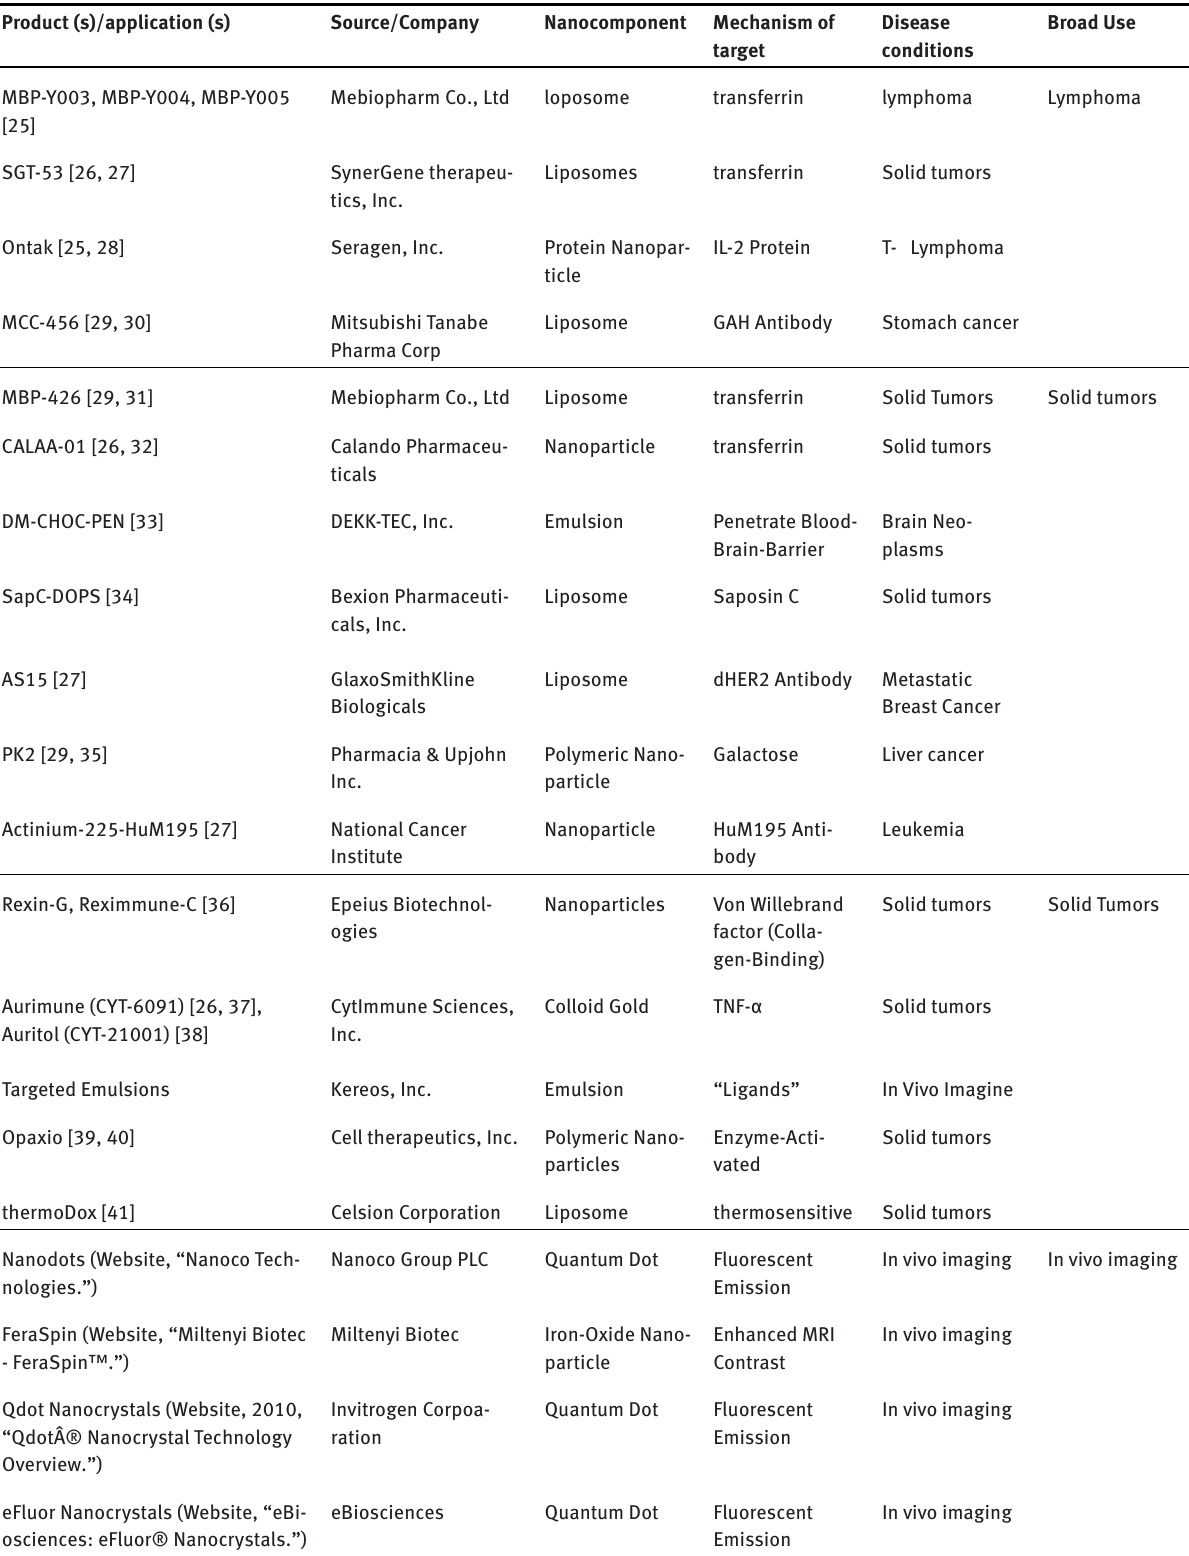
Table 1: Products that are in development and have gained approval through one stage or another. Product (s)/application